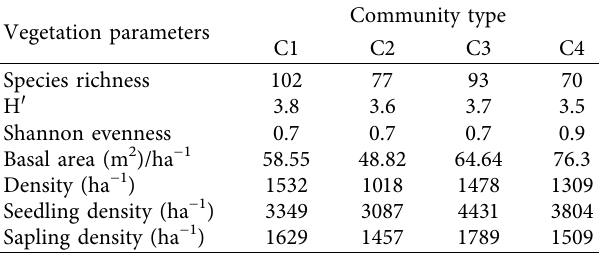
Table 7: Species richness, evenness, and diversity indices of plant community types.